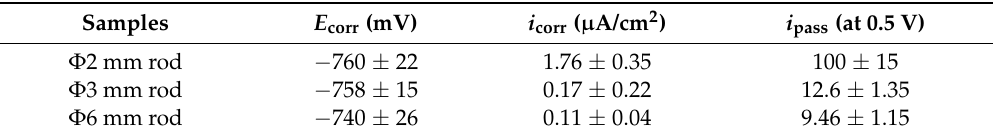
Table 1. Calculated corrosion parameters of all Ti 46 Zr 20 V 12 Cu 5 Be 17 composites rods using the Tafel extrapolation method.